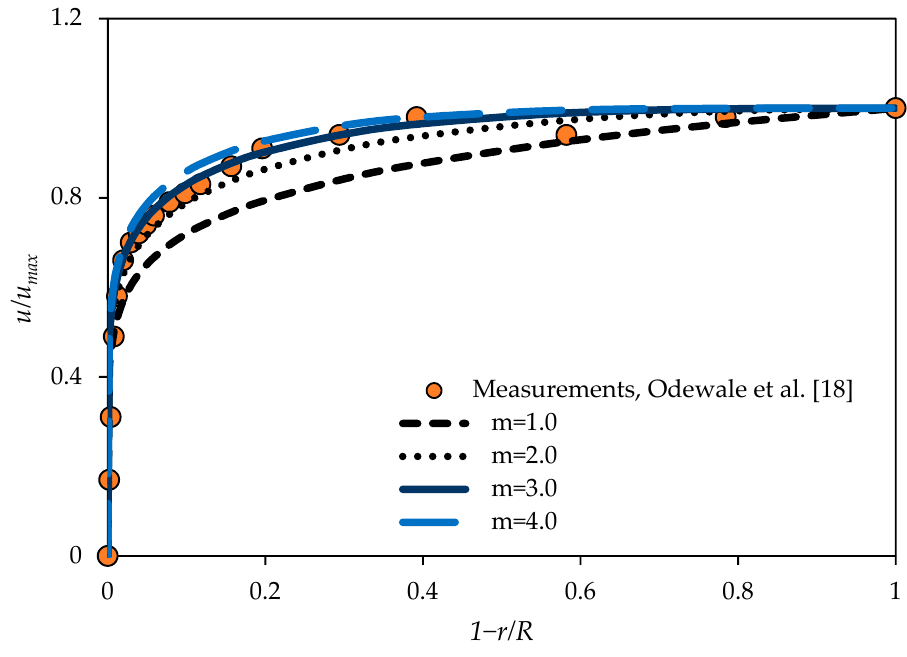
Figure 10. Comparisons between measured and calculated normalized velocity profiles when m takes the values of 1, 2, 3, and 4 and n takes the value of 7.